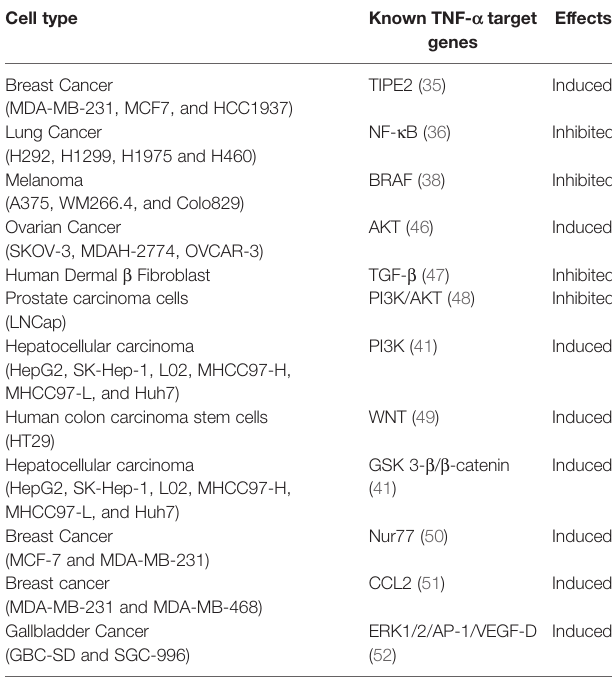
TABLE 1 | The roles of TNF- a in different cancer types. TABLE 2 | The roles of TNF- a in different transcription factors, cytokines, and signaling pathways by cancer type. Cell type Known TNF- a target